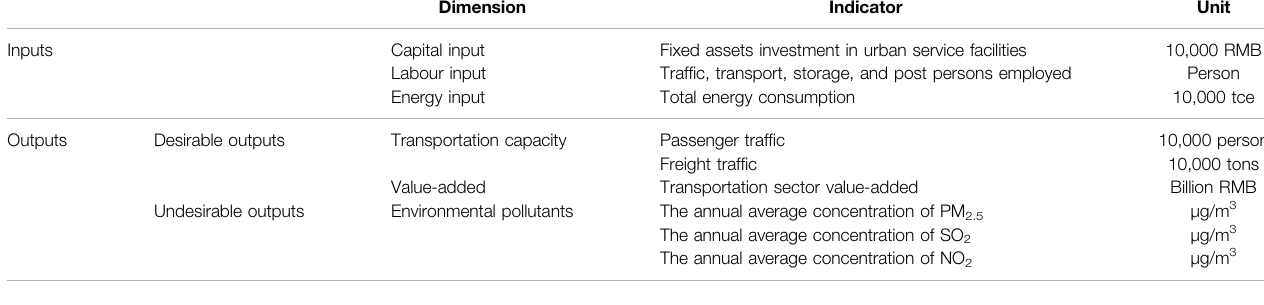
TABLE 2 | EEE evaluation indicators of the transportation system.